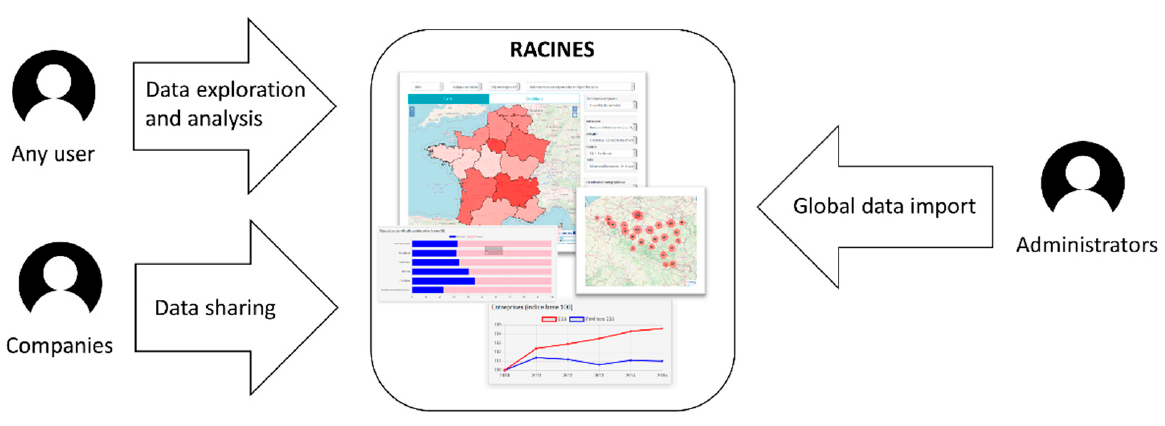
Figure 4. The “Racines” web platform use cases.